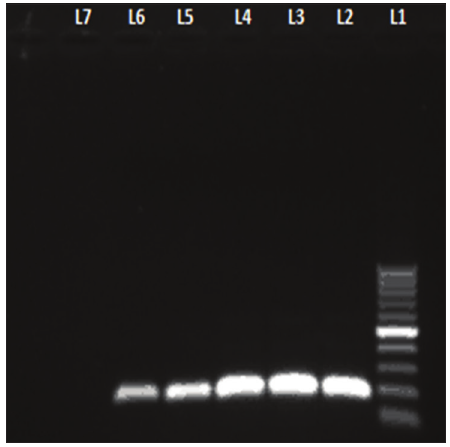
Figure-5: Sensitivity testing shows Lane 1 - 100 bp ladder; Lane 2-6 - Amplicon of 189 bp by second set primers after